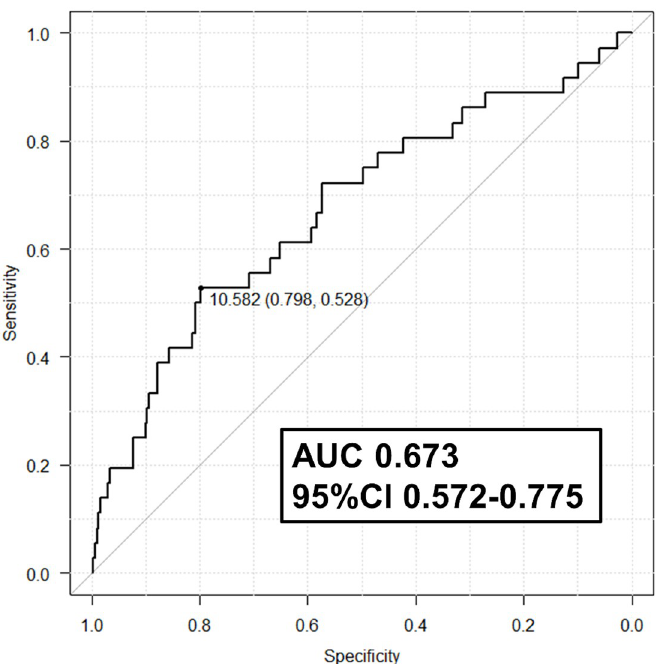
Fig 3. ROC of the area of the bronchial wall for predicting BAL recovery rate failure. The AUC was 0.673 (95% CI 0.572 to 0.775). The cut off value, which was decided by a point of maximum sensitivity and specificity, was 10.6 mm 2 . ROC: receiver operating characteristic curve, AUC: area under the curve, Cl: confidence interval.